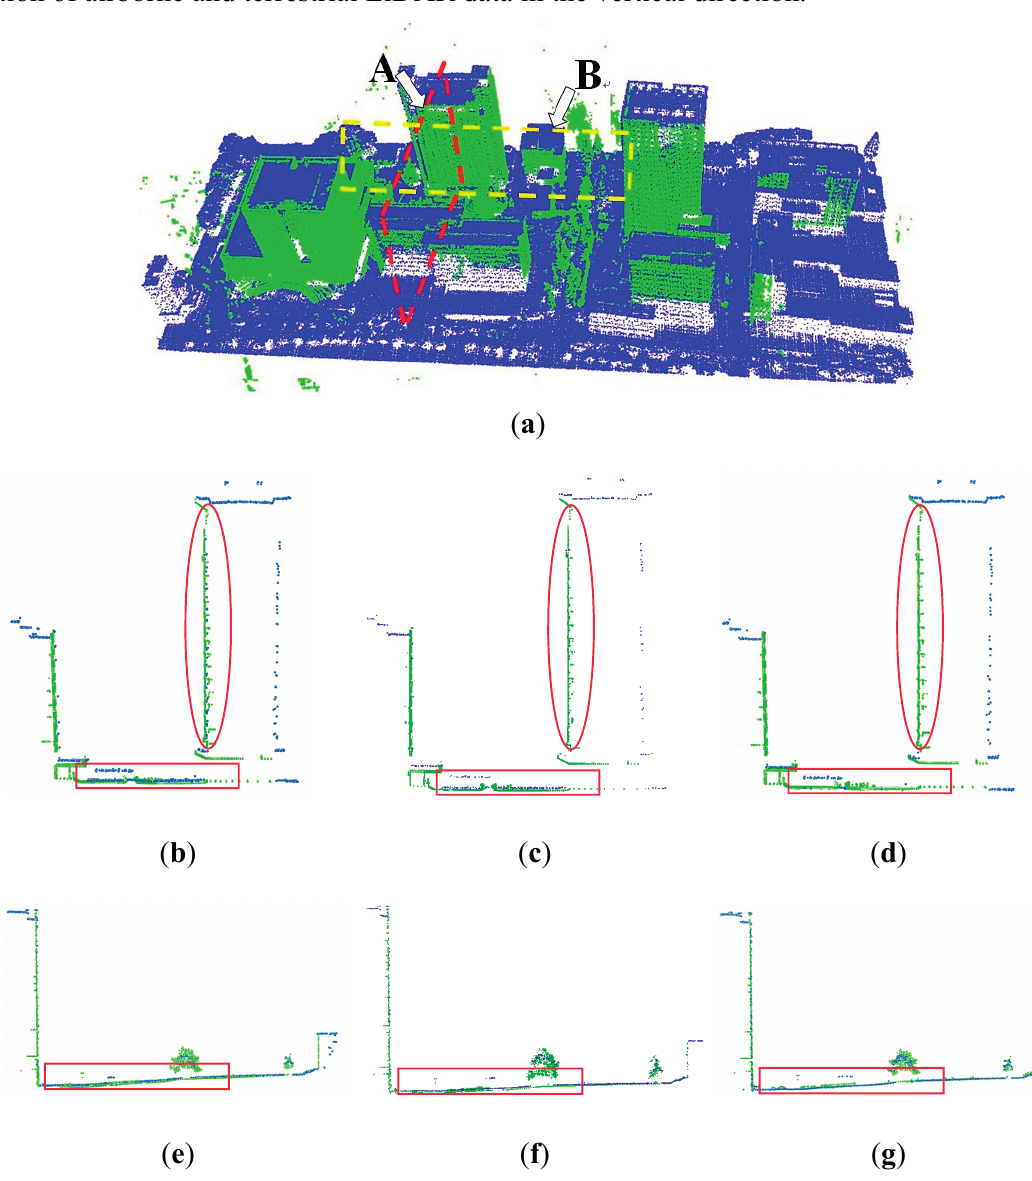
Figure 9. Evaluation with common sections. ( a ) Positions of the sections; ( b ) section A by using FC ; ( c ) section A by using RC ; ( d ) section A by using SC ; ( e ) section B by using FC ; ( f ) section B by using RC ; ( g ) section B by using SC